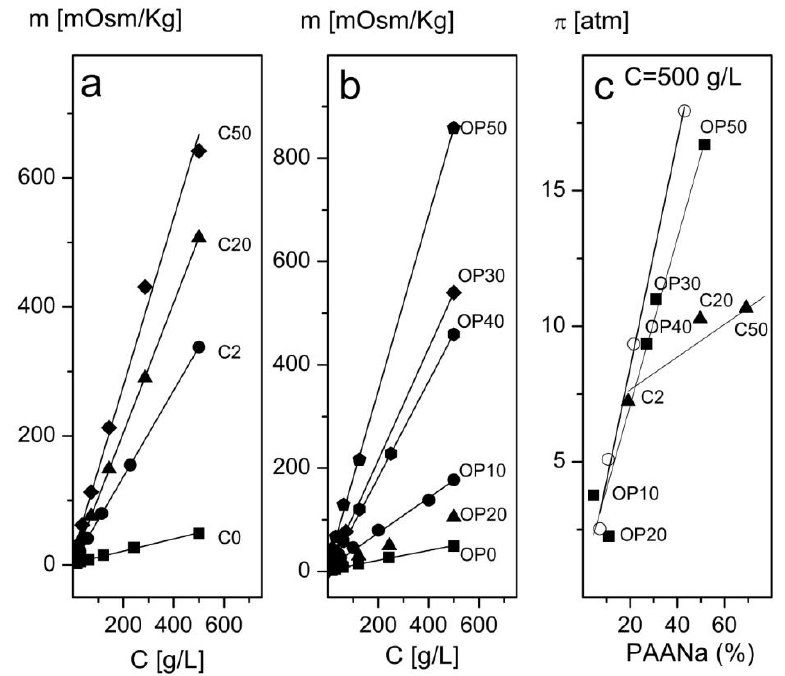
Figure 5. Variation of the osmolality with the concentration for samples of MNCs prepared by coprecipitation ( a ) and oxidative precipitation ( b ) in one step measured at room temperature and pH = 8. In ( c ), we present the evolution of the osmotic pressure with the proportion of PAANa for all of the samples, the results obtained by equivalent aqueous solutions of pure PAANa are presented for comparison (open circles).